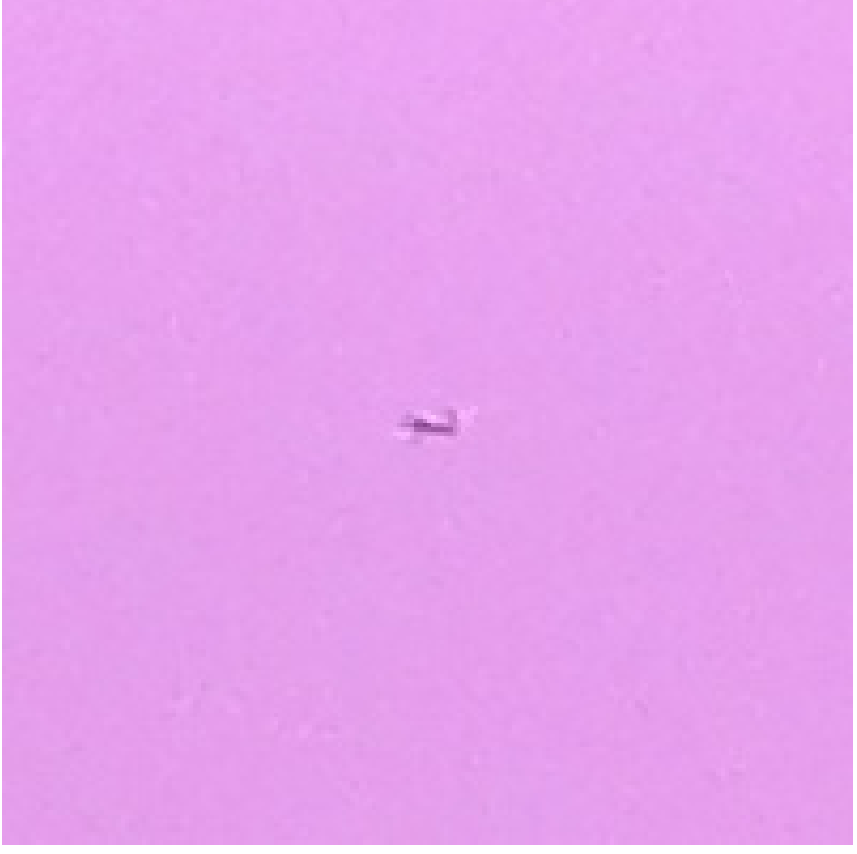
Figure 9. 200 × 200